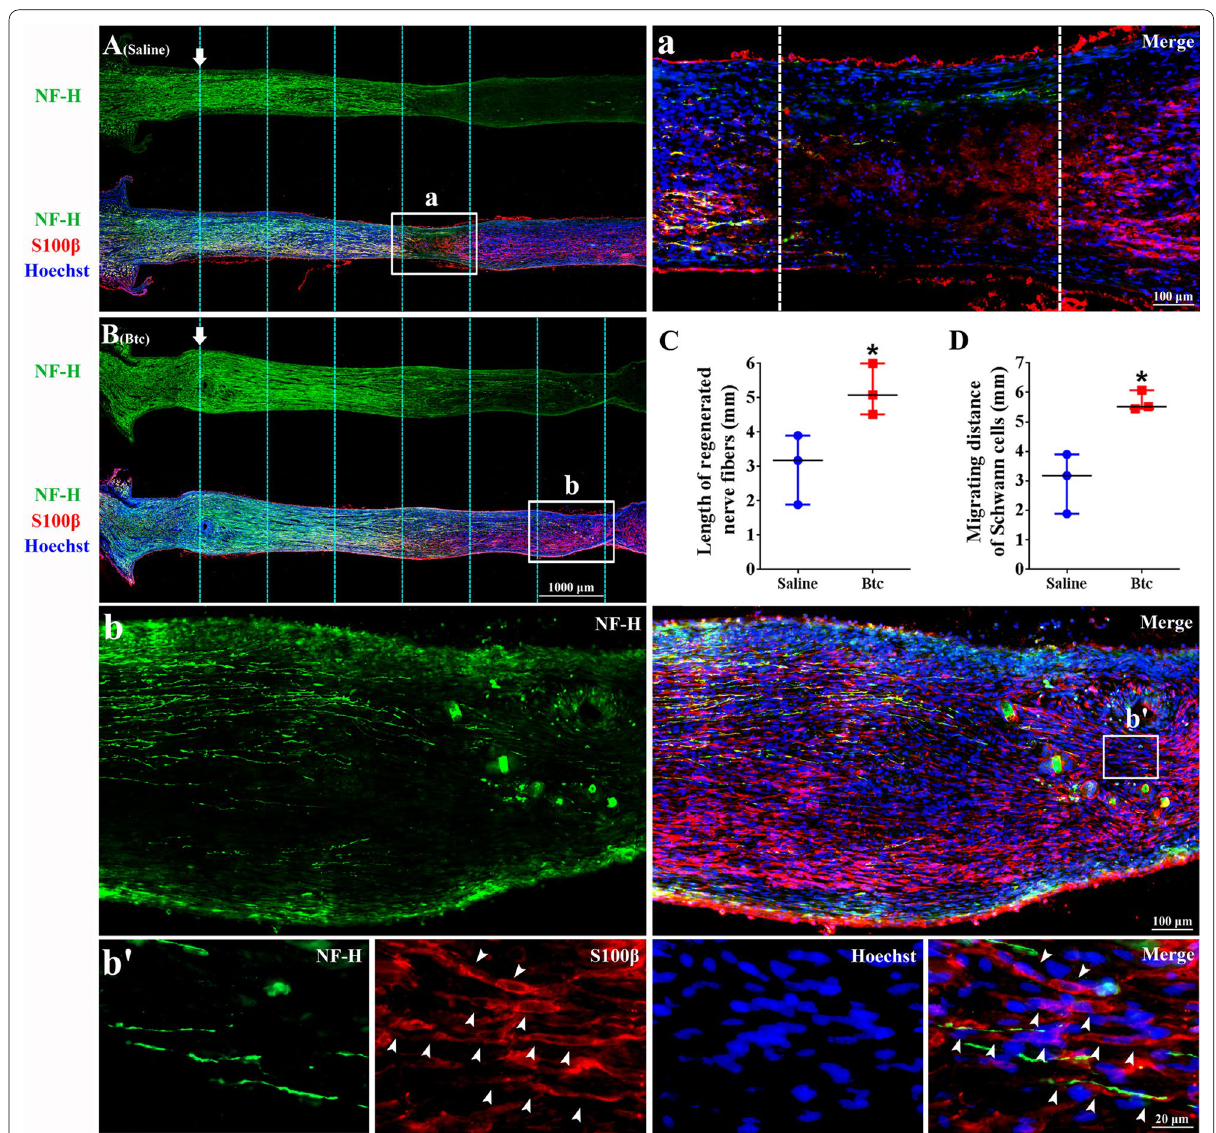
Fig. 6 The in vivo effect of Btc recombinant protein after rat sciatic nerve transection and silicone bridging. Representative immunofluorescence images of rat sciatic nerve segments treated with ( A ) saline control or ( B ) Btc recombinant protein at 10 days after nerve transection and silicone bridging. Green color indicated NF-H, red color indicated S100β, and blue color indicated nucleus. Boxed areas in ( A and B ) were shown in higher magnifications in ( a and b ), respectively. ( b ’) was from boxed area of (b). Arrows indicated the regeneration site. Arrowheads indicated Schwann cell-formed cord in the nerve bridge. Scale bars indicated 1000 µm in ( A and B ) and indicated 100 µm in ( a and b ) and 20 µm in ( b’ ). ( C and D ) Averaged ( C ) length of regeneration nerve fibers and ( D ) migrating distance of Schwann cells summarized from three experiments. Statistical evaluation was performed using t-test. *p-value < 0.05 versus saline